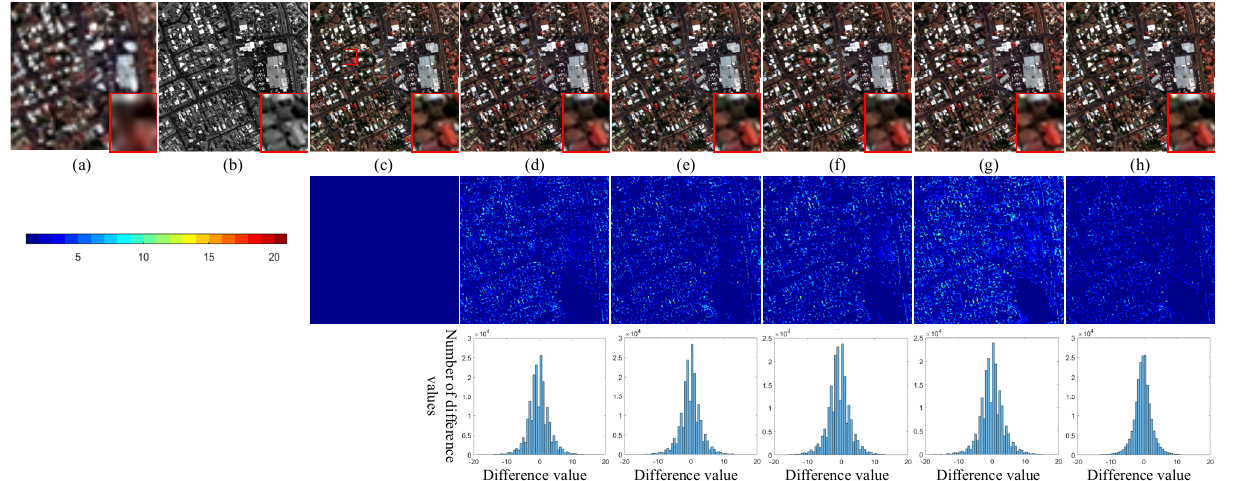
Figure 9. Ablation study of different modules on the GeoEye-1 dataset. ( a ) LR MS image; ( b ) PAN image; ( c ) reference image; ( d ) w/o transformer block; ( e ) w/o SIAM; ( f ) w/o pixel shuffle; ( g ) w/o MRM; ( h ) complete MSIT.